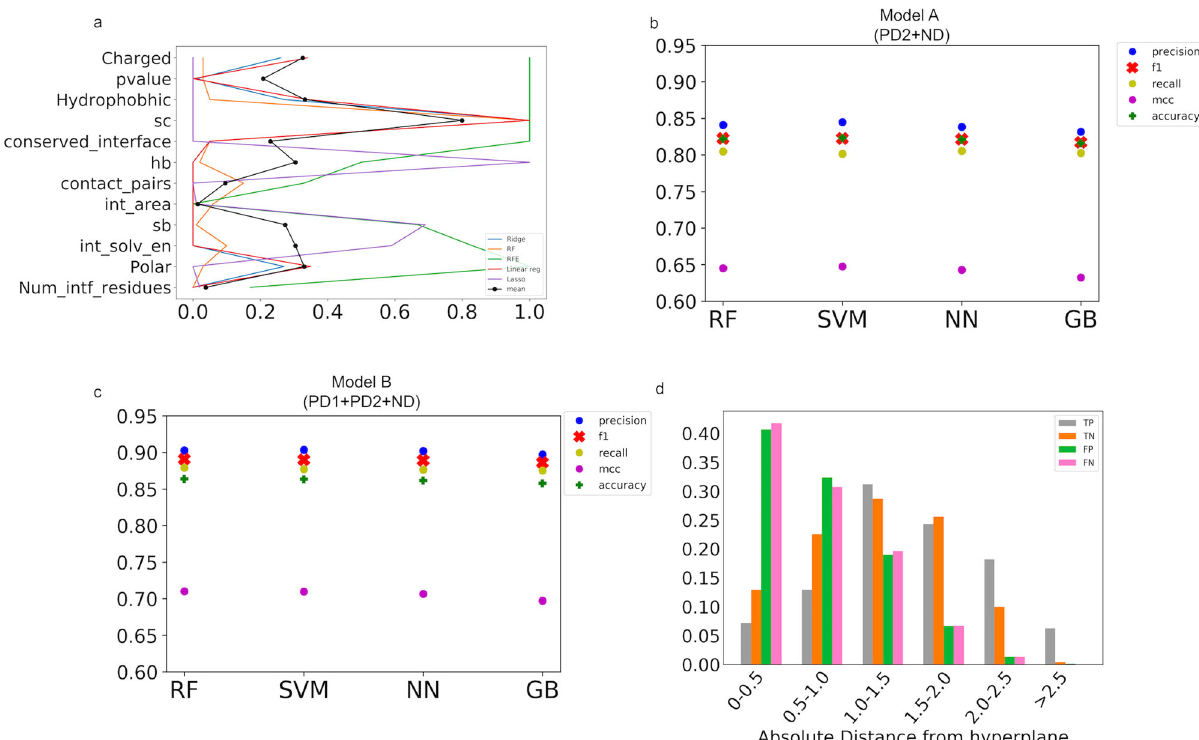
Fig. 2 Machine learning-based classi fi er to assess the quality of protein – protein interfaces. a Importance of interface features in distinguishing the ‘ native-like ’ interface. The ranks calculated using different methods (Ridge, Random Forest (RF), Recursive feature elimination (RFE), Linear regression (Linear reg) and Lasso) were normalised between 0 and 1 and the mean feature rank is plotted in black. b , c Performance of different classi fi ers on the training dataset: RF (random forest), SVM (support vector machine), NN (neural networks), and GB (gradient boost) are used to perform supervised learning on the training dataset using strati fi ed shuf fl e split as a means of cross-validation with ten splits. The performance is evaluated using accuracy, precision, F1, recall scores and Matthews correlation coef fi cient. Performance measures of Model A ( b ): trained on docking-derived positive dataset (PD2) and negative dataset (ND). Performance measures of Model B ( c ): trained using both high-resolution and docking-derived positive datasets (PD1 + PD2) and negative dataset (ND). d Fraction of true positives (TP), true negatives (TN), false positives (FP) and false negatives (FN) in different PI-score thresholds. The fractions ( Y -axis) are averaged over the ten splits ( strati fi ed shuf fl e split ) of the data. The different PI-score thresholds ( X -axis) are indicated in absolute